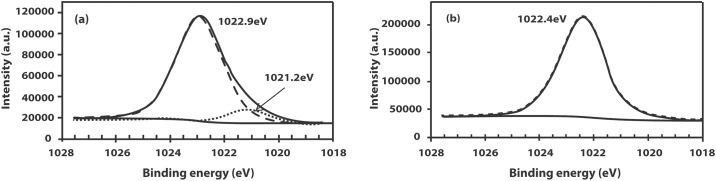
The Zn 2p3/2 peak of (a) W10 (b) W7.